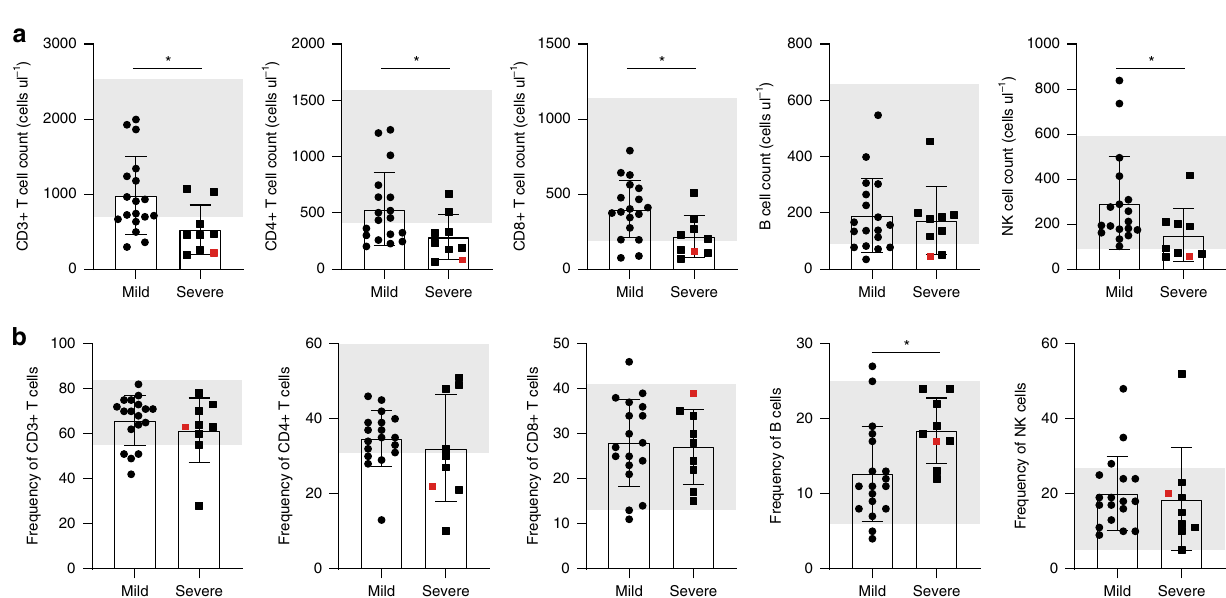
Fig. 1 Absolute cell counts and percentages of peripheral lymphocyte subsets in SARS-CoV-2 infected patients. a Absolute cell counts and b percentages of CD3 + T cells, CD4 + T cells, CD8 + T cells, B cells, and NK cells in the mild ( n = 18) and severe ( n = 9) group were analyzed by fl ow cytometry. Shaded region showing the normal range of indicated cell subset. Colored symbols indicated deceased cases. Data are expressed as mean ± SD. * p < 0.05 by two-tailed Mann – Whitney U -test for a ( p = 0.0124, p = 0.0354, p = 0.0199, and p = 0.0354, respectively) and b ( p = 0.015). Source data included as a Source Data